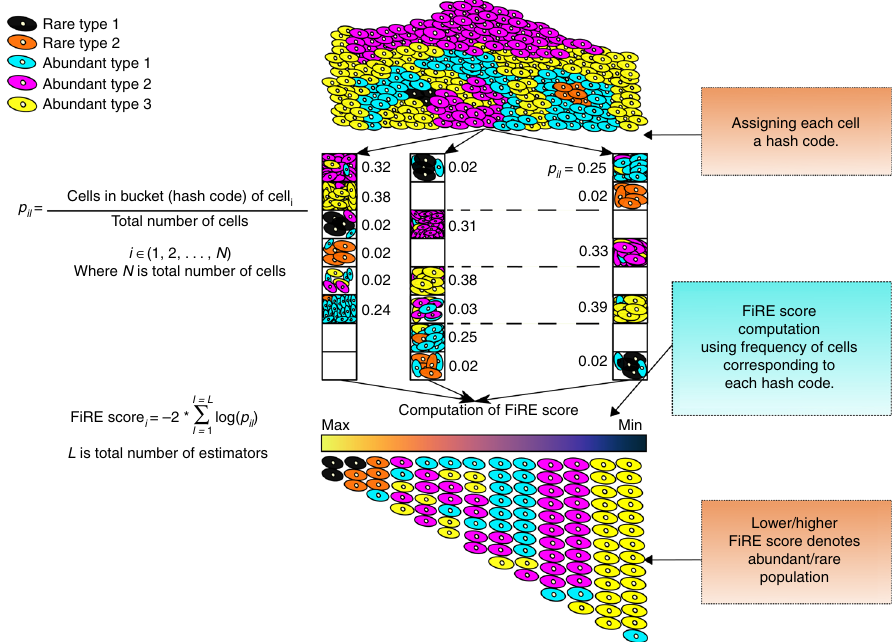
Fig. 1 Overview of FiRE. The fi rst step is to assign each cell to a hash code. A hash code can be considered as an imaginary bucket since multiple similar cells can share a hash code. For the robustness of rarity estimates, the hash code creation step is repeated for L times. For each cell i and estimator l , p il is computed as the probability for any point to land in the bucket of i . The second step of the algorithm involves combining these probabilities to obtain a rareness estimate for each cell